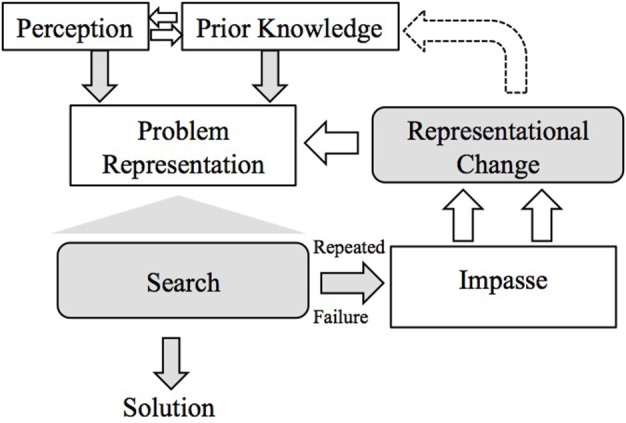
Öllinger et al. (2014b) stage model of insight problem solving (original figure).